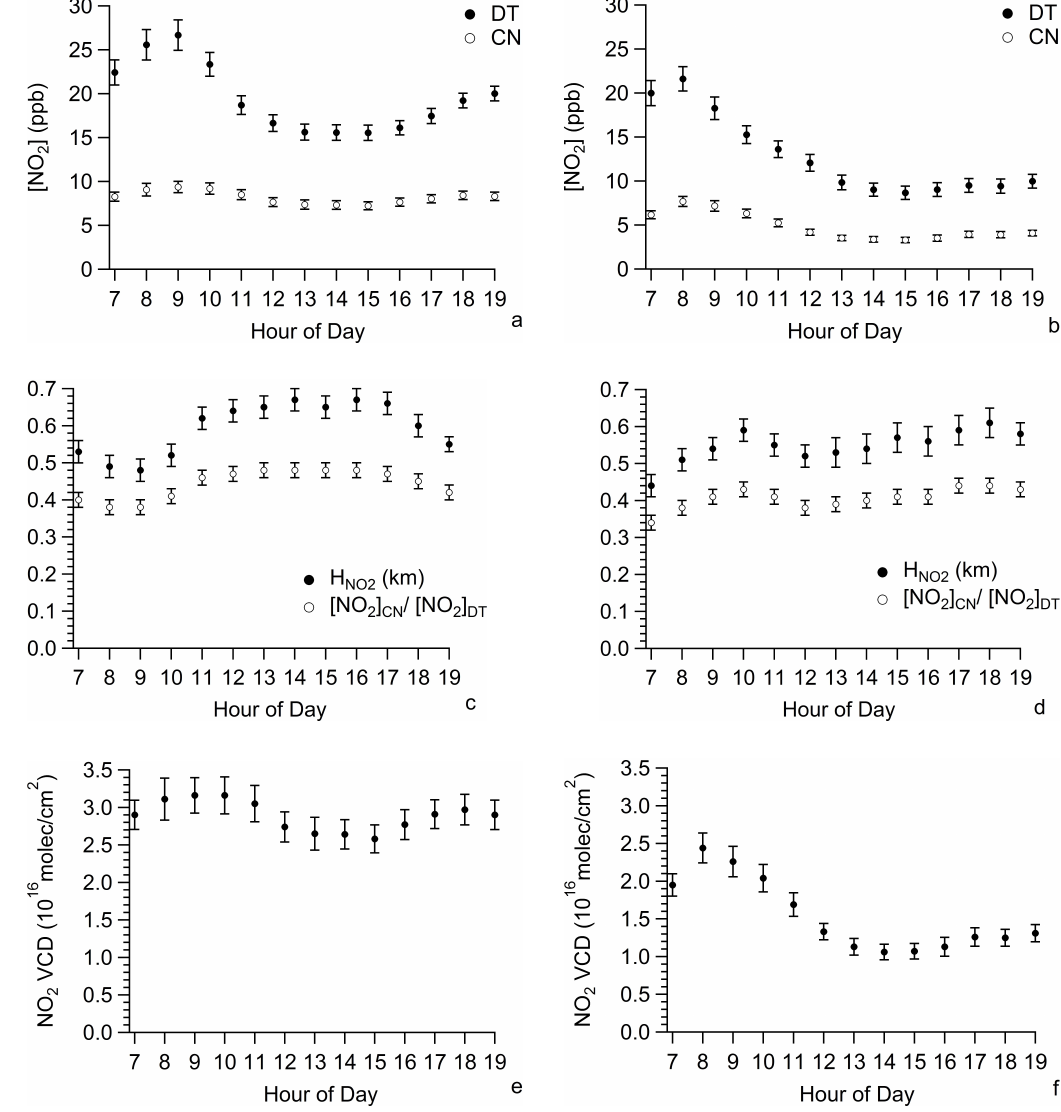
Fig. 4. (a) Diurnal profile of [NO 2 ] at DT and CN during the months of December–March and (b) May–August. (c) Diurnal profile of H NO and [NO 2 ] CN / [NO 2 ] DT during the months of December–March and (d) May–August. (e) Diurnal profile of NO 2 VCD during the months of December–March and (f) May–August. Plots were derived by applying all criteria in Table 3 during the hours of 07:00–19:00EST for hourly averaged data having H NO within 10th to 90th 2